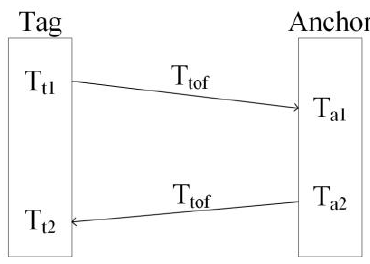
Figure 1. Time of flight (TOF) two-way ranging algorithm principle.